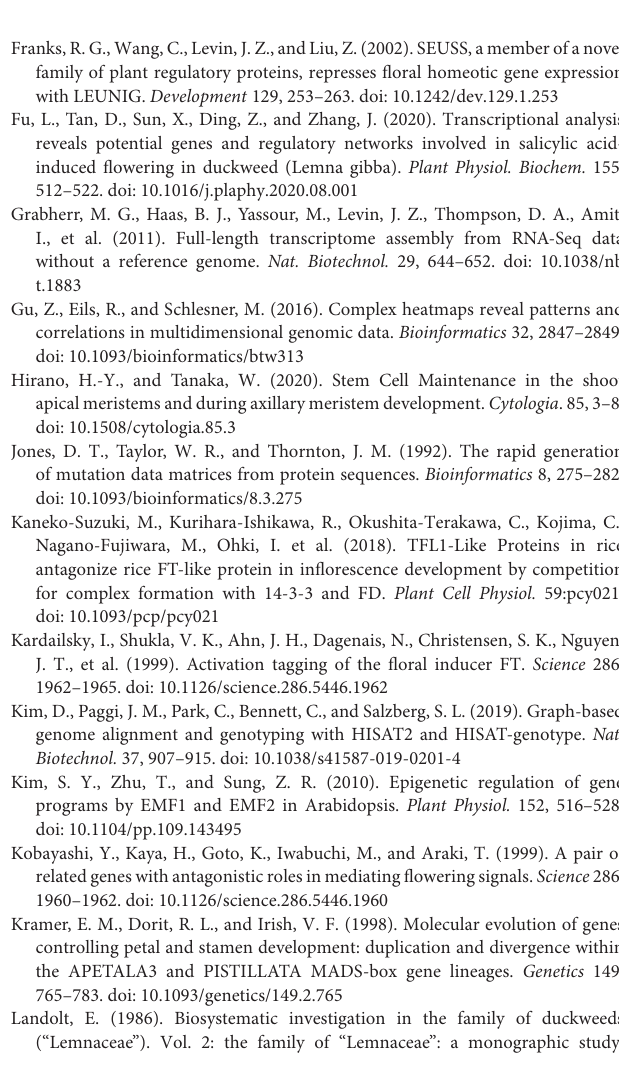
Supplementary Figure 1 | (A) Expression patterns of L. aequinoctialis orthologs of photoperiodic flowering-related genes ( GI , CO, SOC1 ), flower development-related genes ( AP1 , DEF/GLO , AG, LFY ) and the anti-florigen gene TFL1 . The number of days after short-day treatment is shown on the x-axis, and the logarithmically transformed count per million reads (CPM) + 1 values are shown on the y-axis. (B) A heatmap of DEGs associated with floral development and flowering related GOs. Heatmap of log ratio of expression variation from 0SD is shown. Supplementary Table 1 | Summary of sequenced reads and alignment statistics. Supplementary Table 2 | Summary of assembled transcriptome. Supplementary Table 3 | Differentially expressed genes. Supplementary Table 4 | Gene ontology enrichment. Supplementary Table 5 | Gene IDs and Accession